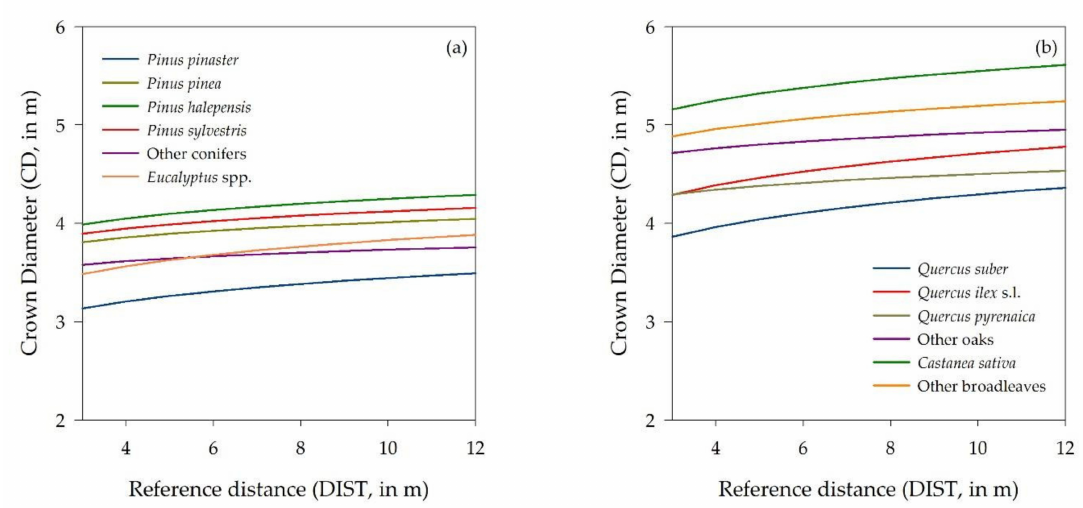
Figure 10. Crown diameter (CD) of a tree with 20 cm of Diameter at Breast Height (DBH) as a function of a reference distance (DIST) to neighbor trees: conifers and eucalypts ( a ), and oaks and other broadleaves ( b